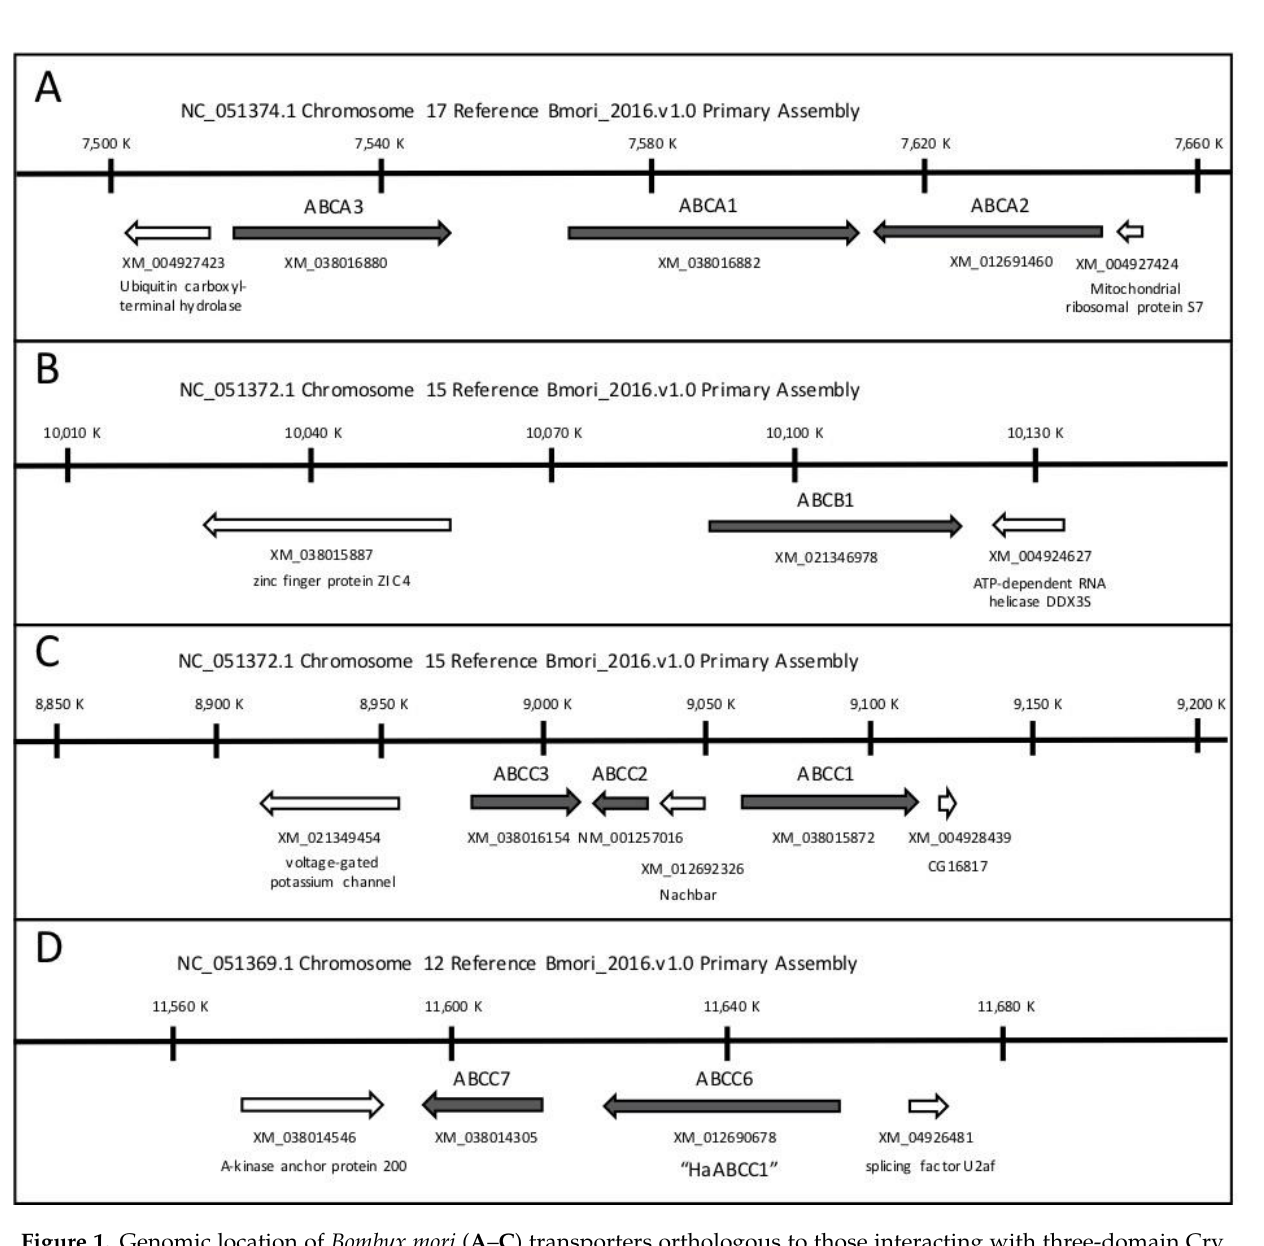
Figure 1. Genomic location of Bombyx mori ( A – C ) transporters orthologous to those interacting with three-domain Cry proteins described in the text. Coordinates are based on the chromosome view on NCBI (https://www.ncbi.nlm.nih.gov/, accessed on 2 April 2021) and are the same as shown in the new version of Kaikobase [9] . ( D ) Names for ABCC6 and ABCC7 are defined here for the first time, to avoid confusion with the previously named ABCC1.